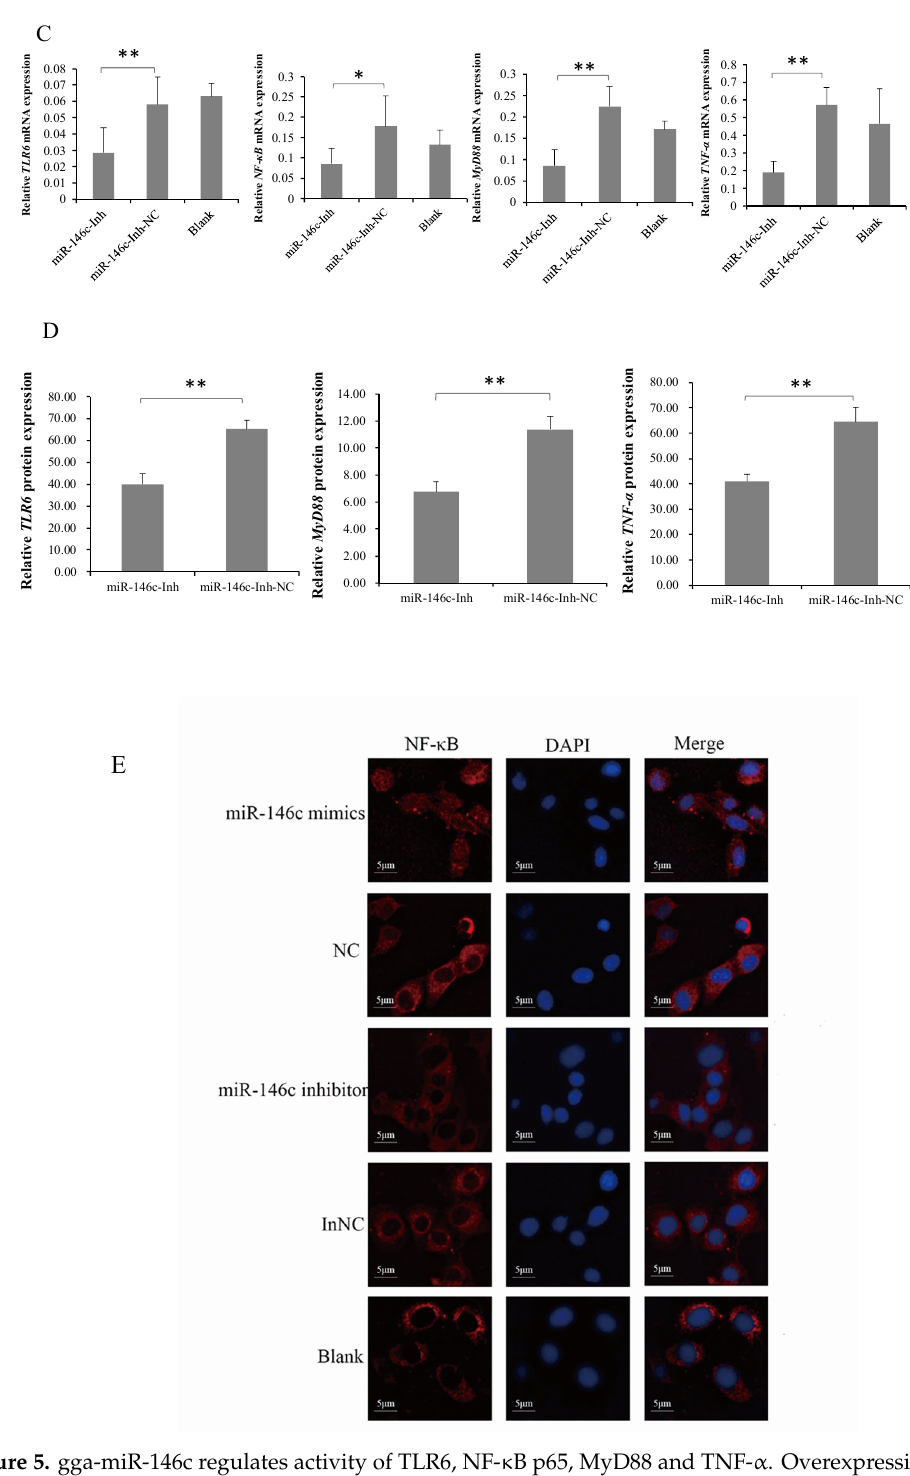
Figure 5. gga-miR-146c regulates activity of TLR6, NF- κ B p65, MyD88 and TNF- α . Overexpression of gga-miR-146c activates TLR6, NF- κ B p65, MyD88, and TNF- α after 48 h transfection. ( A ) Expressions of TLR6, NF- κ B p65, MyD88, and TNF- α were measured via RT-qPCR; ( B ) Protein expressions of TLR6, MyD88, and TNF- α wer measured through ELISA. Inhibition of gga-miR-146c reduced TLR6, NF- κ B p65, MyD88, and TNF- α expressions in DF-1 cells 48 h post-transfection; ( C , D ) The mRNA and protein expressions of TLR6, NF- κ B p65, MyD88, and TNF- α were measured through RT-qPCR or ELISA, respectively, normalized to GAPDH; Values are mean ± SD, * p < 0.05, ** p < 0.01; ( E ) DF-1 cells were respectively transfected with gga-miR-146c, negative control, miR-146c-Inh or miR-146c-Inh-NC.The mock transfection served as blank. Stained macrophages were magnified 200 × . gga-miR-146c overexpression made NF- κ B p65 (red) turning into the cell